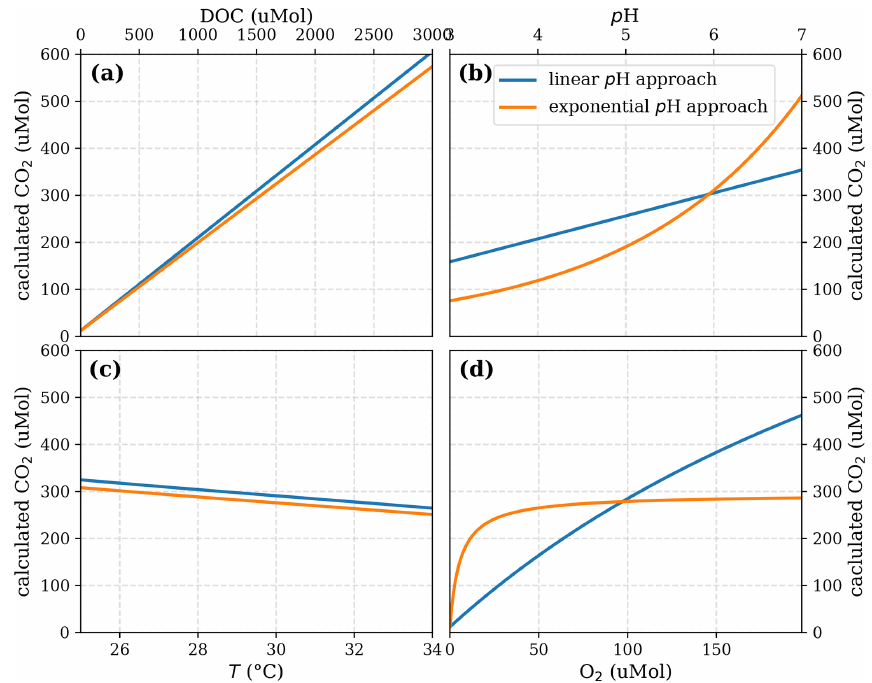
Figure A2. Functional dependencies of CO 2 on (a) DOC, (b) pH, (c) temperature ( T ), and (d) O 2 according to the equation in Table 1 (linear pH approach) and in Table 2 (exponential pH